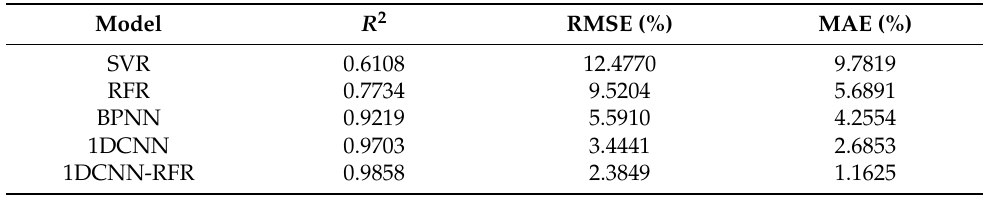
Figure 8. Training loss curve of the 1DCNN framework during training in Experiment B. Table 6. Evaluation of regressions on the test set by the five models in Experiment B using three